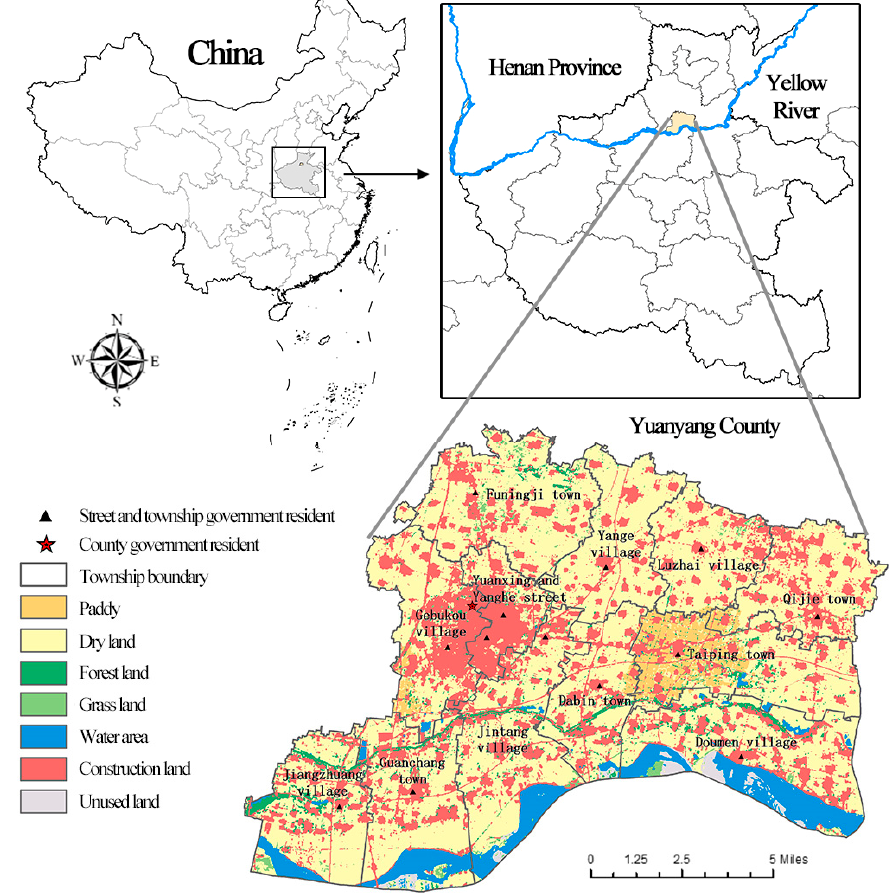
Figure 1. Location and land use of Yuanyang County.